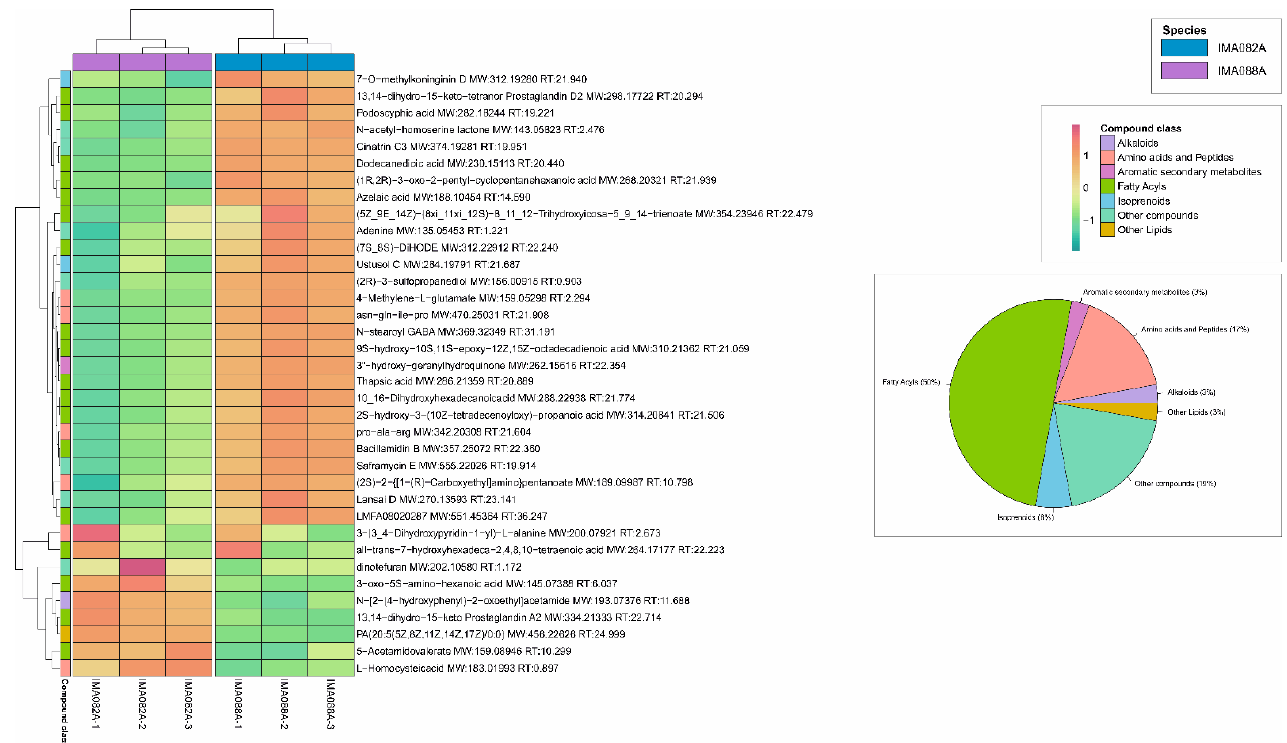
Figure 8. Feature analyses for candidate biomarker selection ( p -values < 0.005). Hierarchical clustering heat map of metabolites between groups in negative ion mode. Colors from red to green indicate the normalized relative abundance values of metabolites from low to high according to the scale bar. Samples of C. ineffabilis IMA082A (blue) and C. zucchellii IMA088A (violet) are disposed in columns; replicates are indicated with suffix numbers 1, 2 and 3. Compound classes are indicated in different colors and percentages of each class are reported on the right side of the figure.